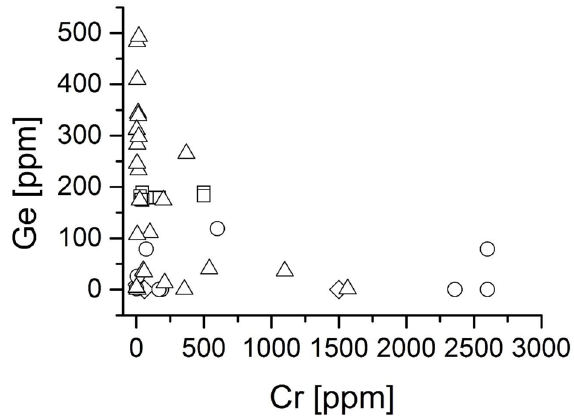
Figure 8. Linear plot Ge against Cr for iron meteorites without plessitic octahedrite Butler (data of Table 2). r = 0.34, Δ octahedrites, o hexahedites, ¡ ataxites, ◊